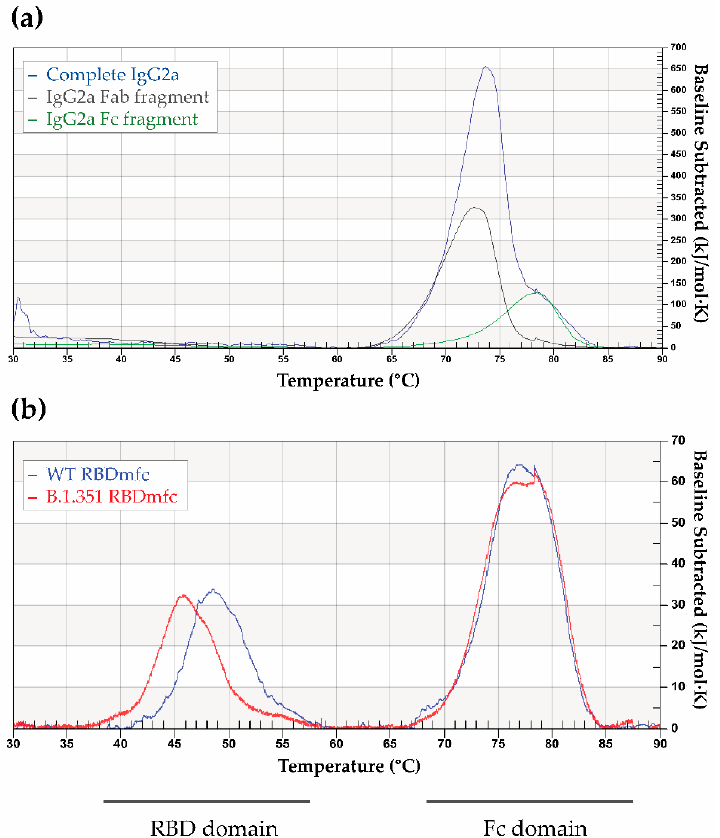
Figure 9. Thermograms of mouse IgG2a Fc fragment ( a ) and of WT and B.1.351 RBDmfc proteins ( b ) acquired by differential scanning calorimetry (DSC). ( a ) DSC was performed on purified mouse IgG2a and on its Fab and Fc fragments obtained upon papain digestion. Mouse IgG2a Fc fragment shows a Tm around 77–78 °C. ( b ) DSC was performed on purified WT and B.1.351 RBDmfc proteins. The Tm of the Fc domain of both proteins overlaps around 77 °C. The RBD domains of WT and B.1.351 recombinant proteins differ in their respective Tm, indicating a reduced thermostability of the RBD domain of B.1.351 RBDmfc vs. that of WT RBDmfc. Tm and reaction enthalpy ( Δ H) were measured from the thermograms for the two denaturation events and compared between WT and B.1.351 RBDmfc. Tm1 and Δ H1 measurements for the two RBD substructures highlighted a higher Tm and Δ H for WT RBD (48.6 °C and 56.0 kcal/mol, respectively) than for B.1.351 RBD (45.9 °C and 52.0 kcal/mol, respectively), whereas Tm2 and Δ H2 for the Fc domain of both RBDmfc proteins showed similar thermodynamical values (Tm2[WT] = 77.2 °C; Tm2[B.1.351] = 77.3 °C; Δ H2[WT] = 121.7 kcal/mol; Δ H2[B.1.351] = 122.0 kcal/mol). Altogether, the DSC thermograms indicate that the RBD domain of the B.1.351 mu- tant presented a reduced thermostability compared to the WT RBD domain, further sup- porting the idea that WT and B.1.351 RBDmfc proteins exhibit different conformations, and that B.1.351 altered conformation involves the RBD subdomain of the RBDmfc fusion protein. 4. Discussion We investigated the impact of naturally occurring SARS-CoV-2 RBD mutations on the production and secretion of a recombinant Fc-tagged RBD protein (RBDmfc) transi- ently expressed in HEK 293 cells. We showed that mutation E484K and the association